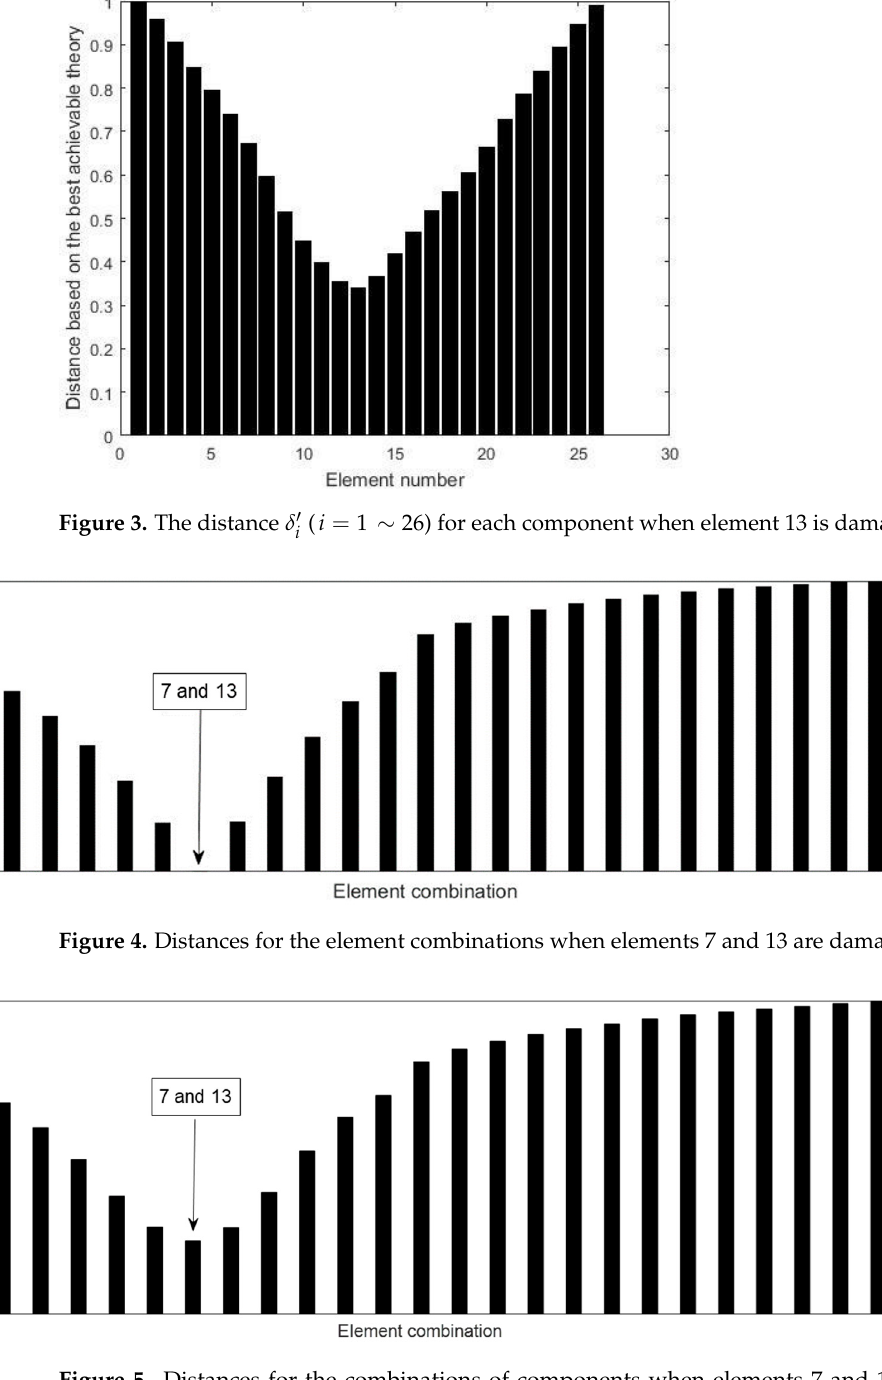
Figure 5. Distances for the combinations of components when elements 7 and 13 are damaged (3% noise).